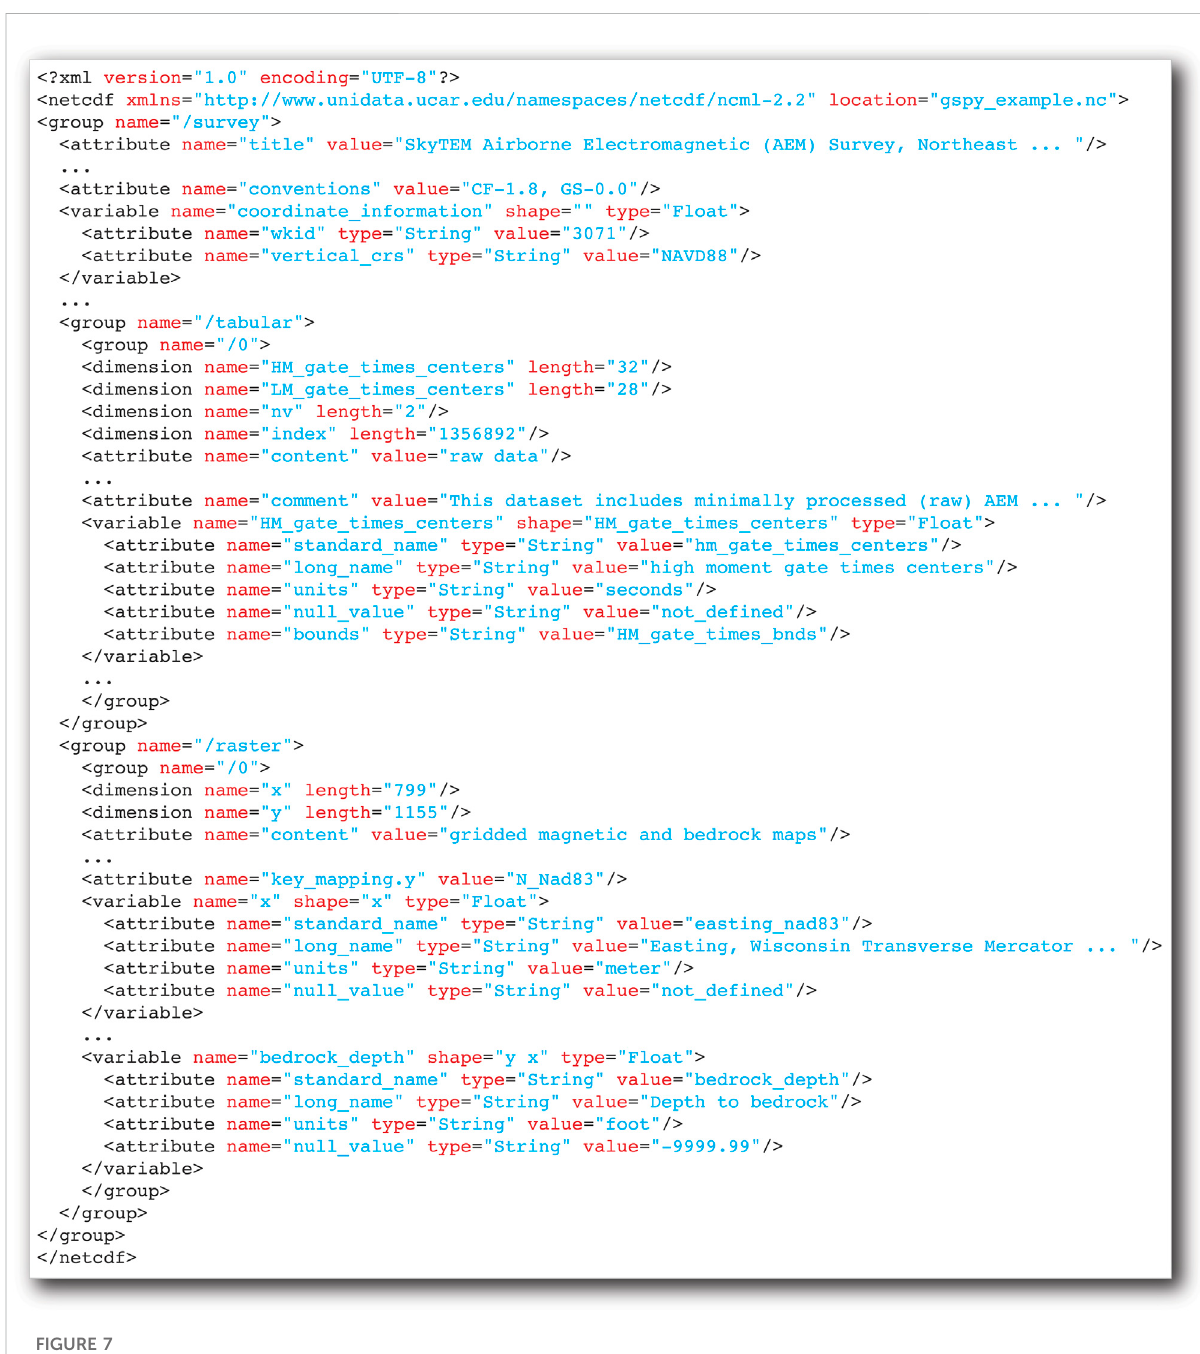
FIGURE 7 ExampleNcML fi le.Duetospaceconstraints,onlyessentialelementsareshownhereforexamplerepresentations.Gapsinvariableandattribute lists are noted by